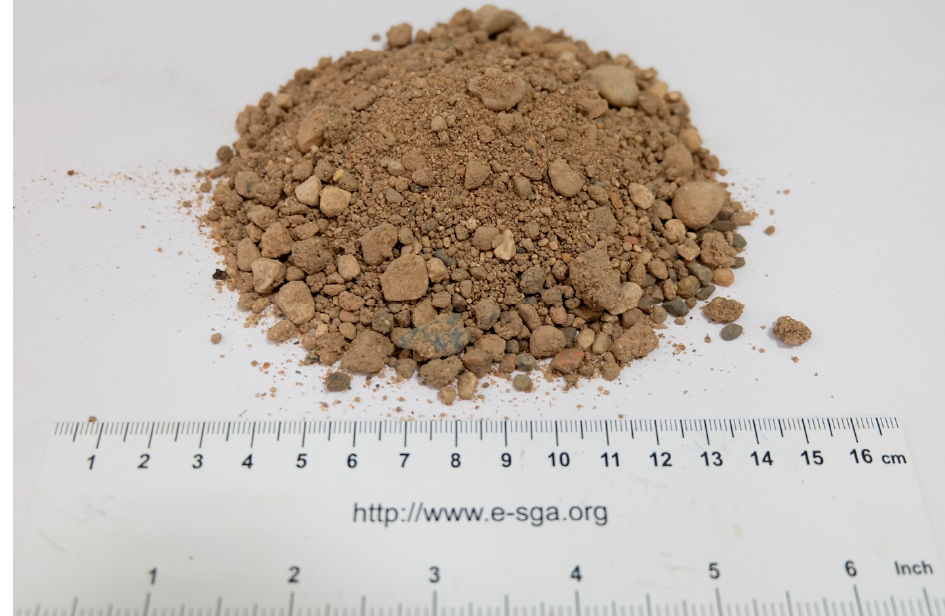
Figure A2. Moraine sand and gravel mix (sample ID 7CA-13), overlying Quaternary fluvioglacial sediments ( Q ), Lomonosov diamond deposit.